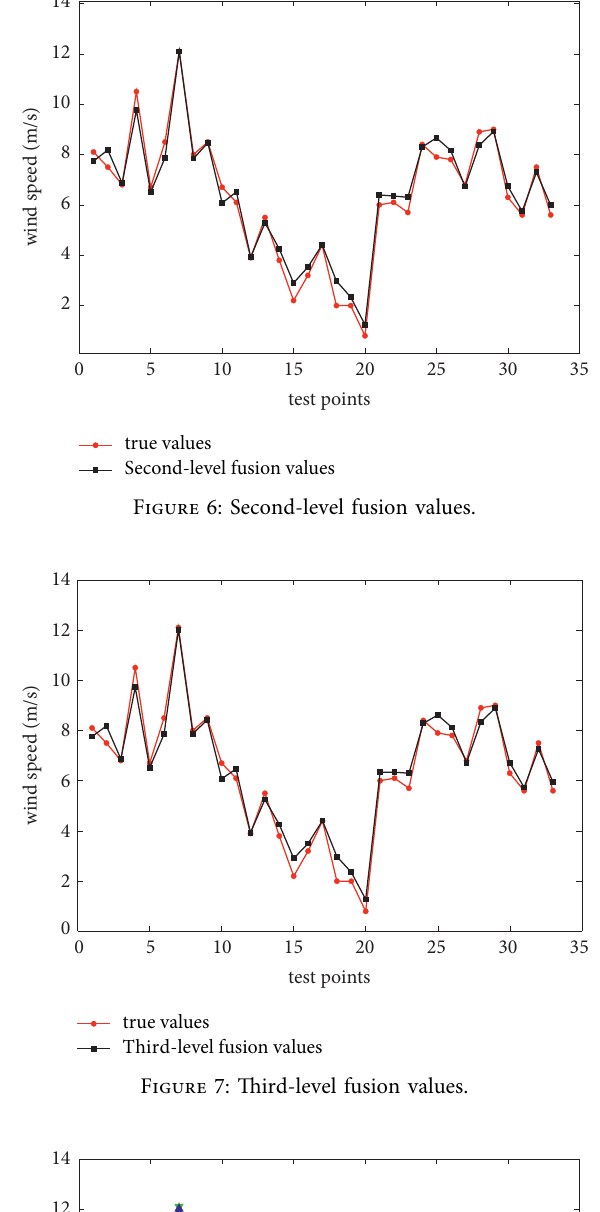
Table 5: Comparison of performance indexes of fusion